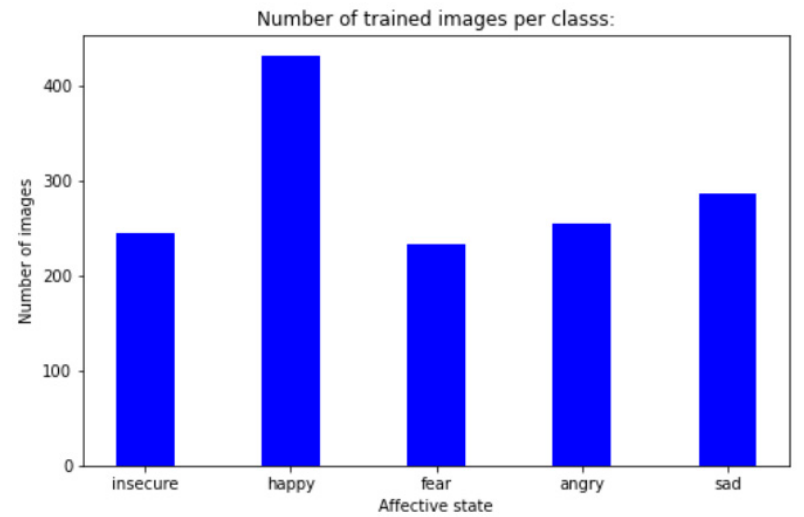
Figure 1. Number of trained images per class.